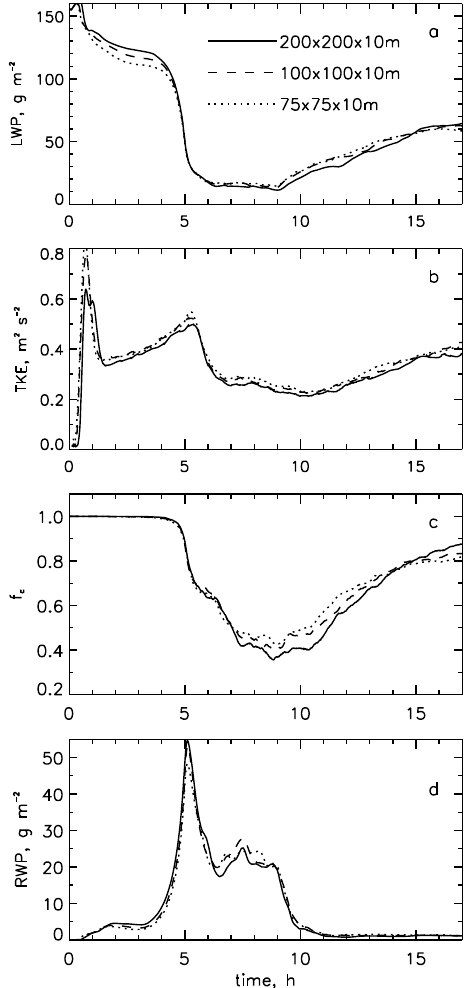
Figure A1. Sensitivity of results to grid spacing